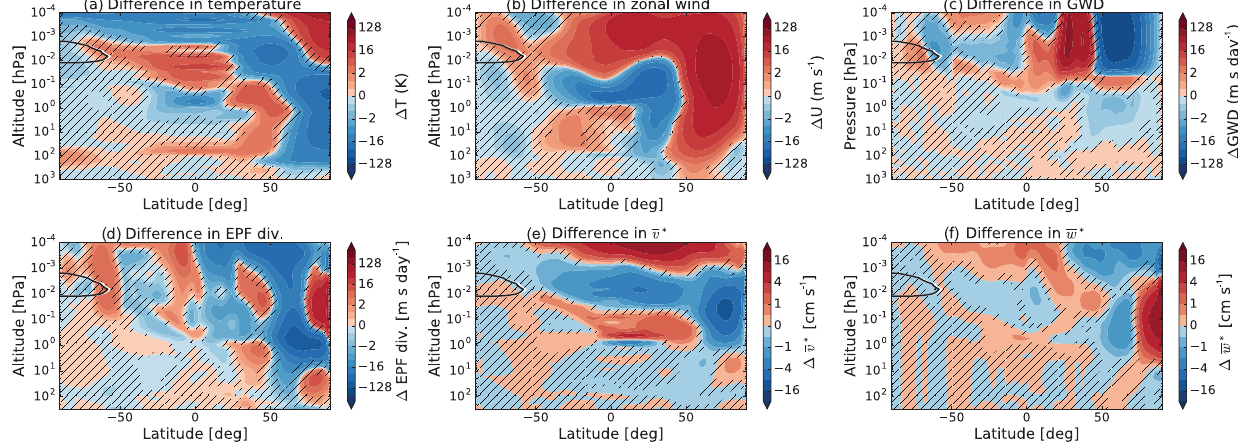
Figure 2. Same as Fig. 1, but for